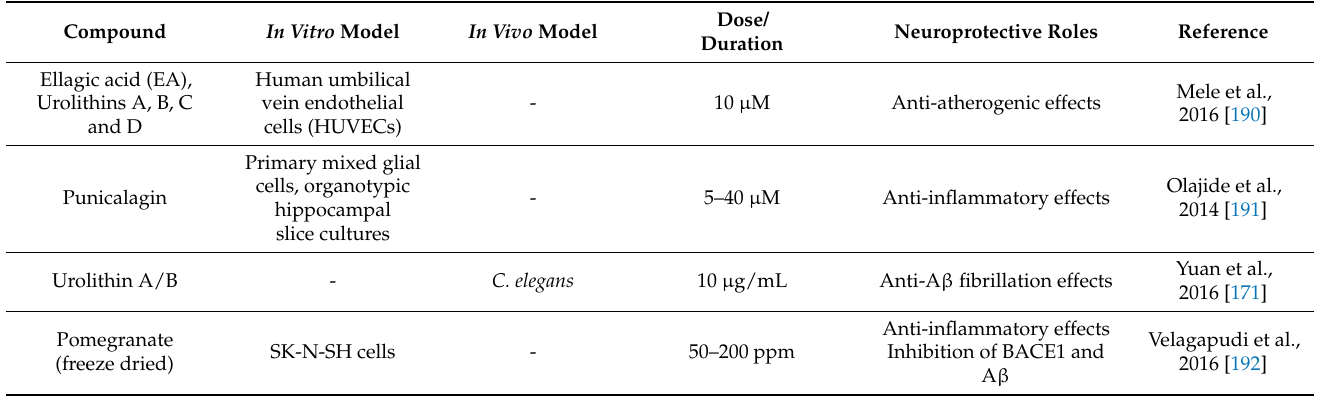
Table 1. Pomegranate/ellagitannins/urolithins-based studies in relation to neuroprotection.